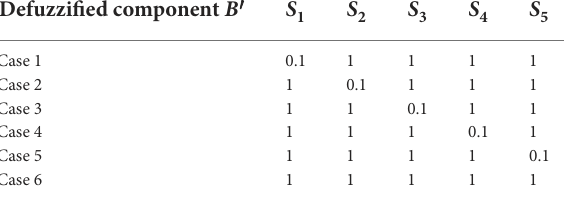
TABLE 15 Six cases of different defuzzified component B ′ .